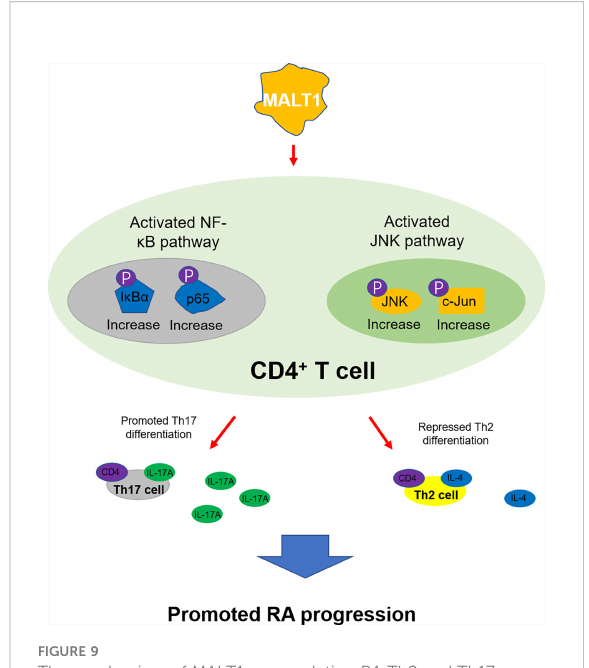
FIGURE 9 The mechanism of MALT1 on regulating RA Th2 and Th17